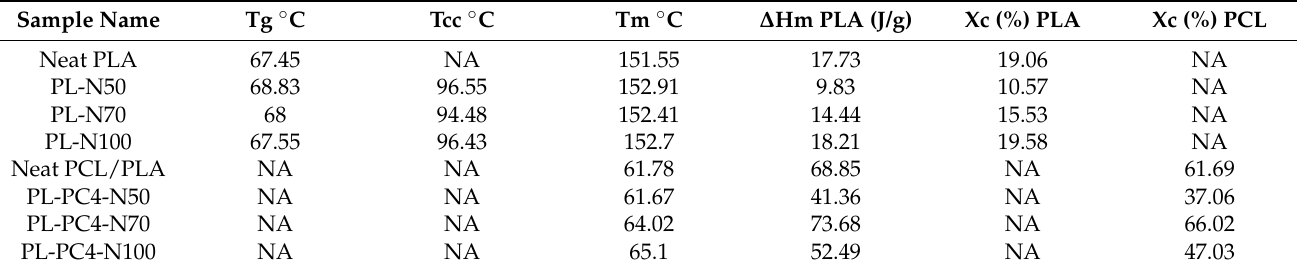
Table 4. Thermal properties of neat and porous PLA and PCL/PLA films.